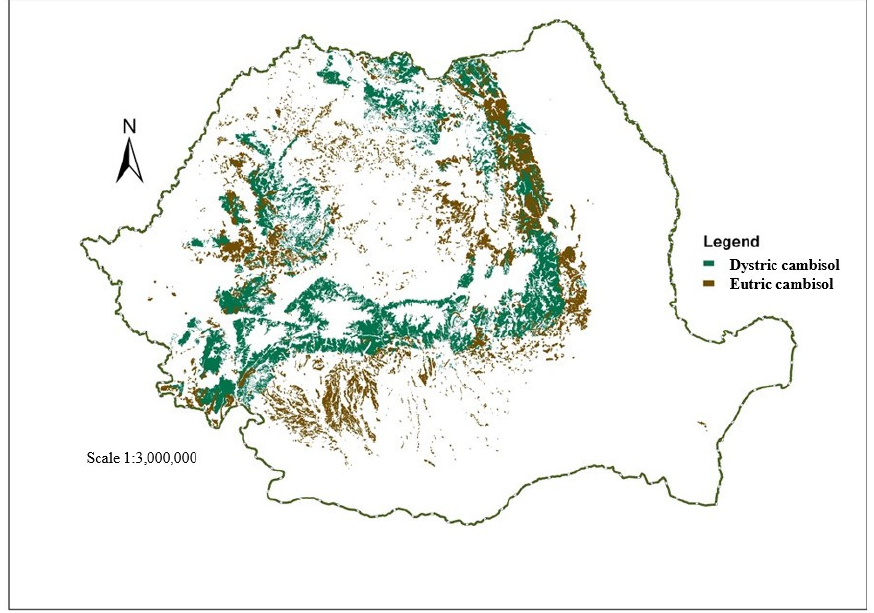
Figure 1. Spread of eutric cambisol and dystric cambisol in forest area of Romania. Statistical